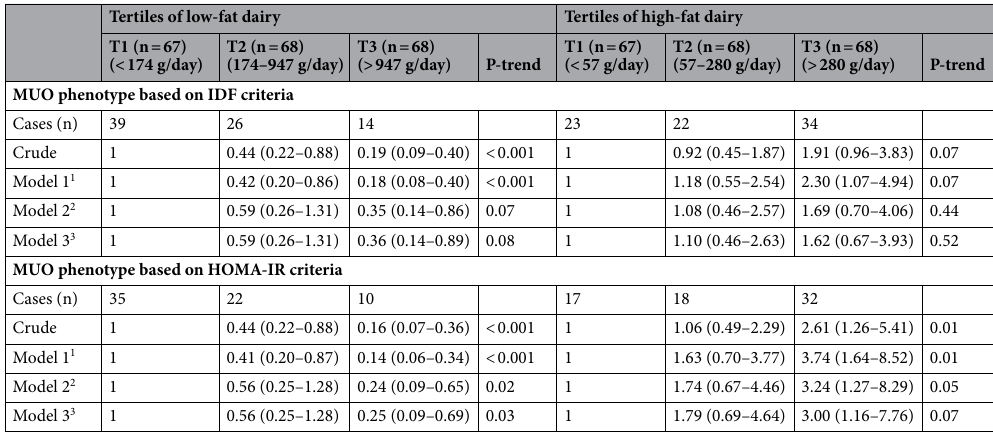
Table 5. Multivariate adjusted odds ratio (OR) and 95% confidence interval (CI) for MUO across energy- adjusted tertiles of low- and high-fat dairy intake. All values are odds ratios and 95% confidence intervals. 1 Model 1: Adjusted for age, sex, total energy intake, and fat intake (percent of energy). 2 Model 2: Additionally, adjusted for physical activity and socioeconomic status (parental education, parental job, number of family members, having car in the family, having computer/laptop, having personal room and having trip). 3 Model 3: Additionally adjusted for body mass index